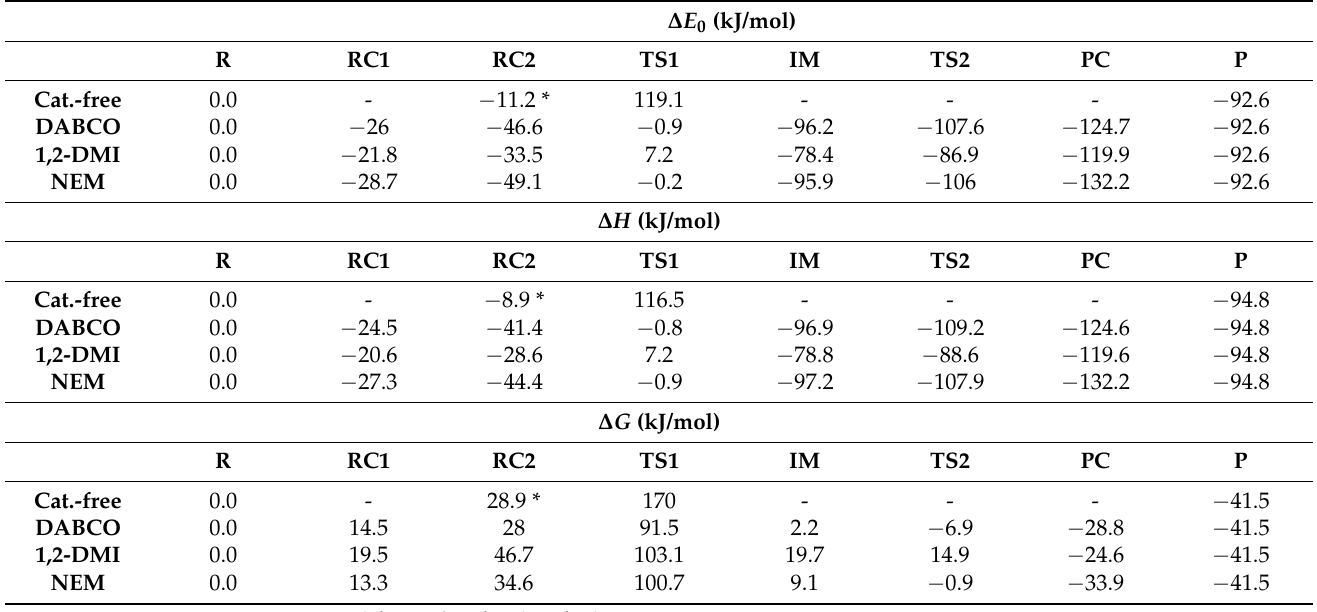
Table 2. Zero-point corrected relative energies ( ∆ E 0 ), relative enthalpies ( ∆ H ), and Gibbs free energies ( ∆ G ) of the reaction between phenyl isocyanate and butan-1-ol in the presence of the studied catalysts, (NEM), calculated at the G3MP2BHandHLYP level of theory in acetonitrile using the SMD implicit